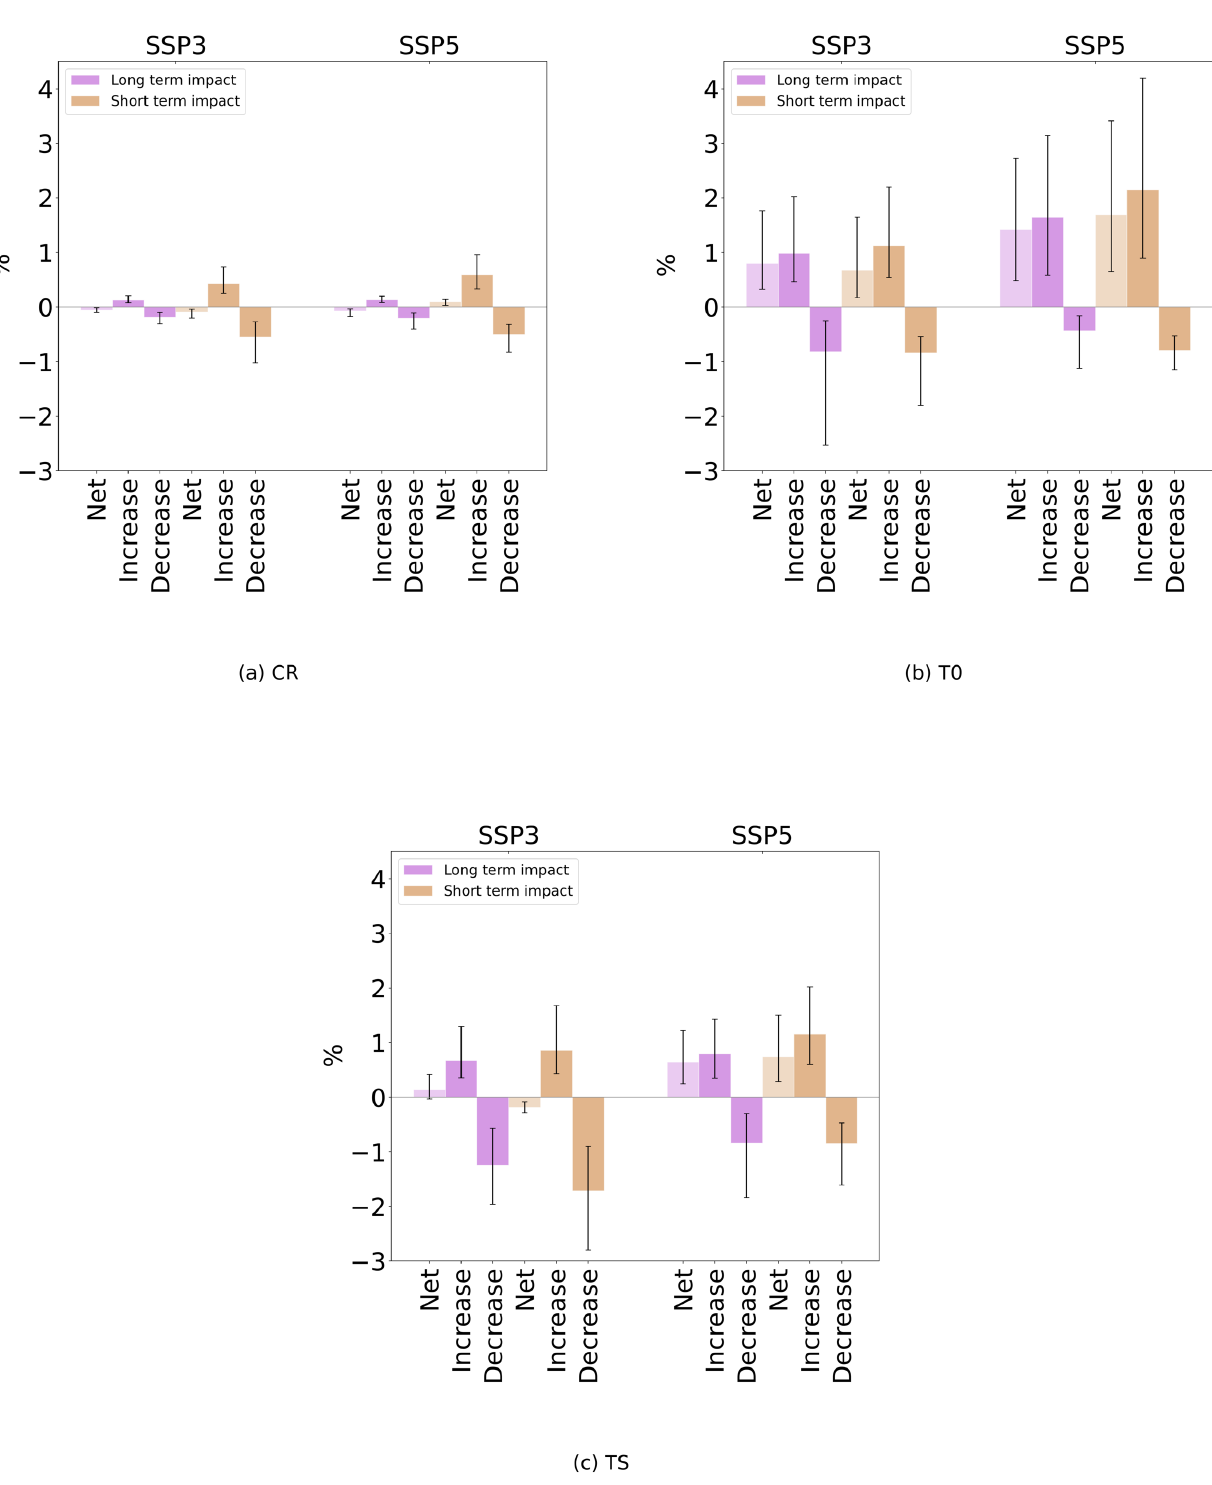
PLOS ONE | https://doi.org/10.1371/journal.pone.0276764 November16, 2022 14 /